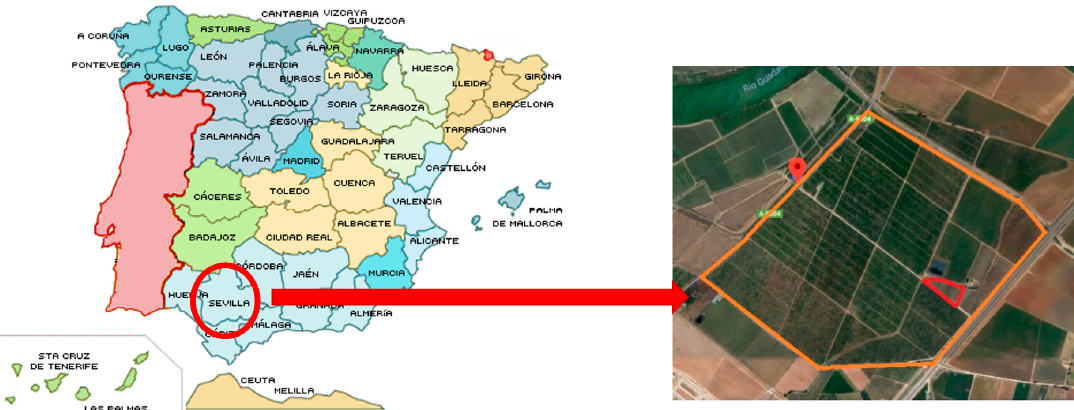
Figure 1. Commercial orchard “Cartuja” in Seville (SW Spain) and the experimental area used for the experiment with 1.8 ha (red area).